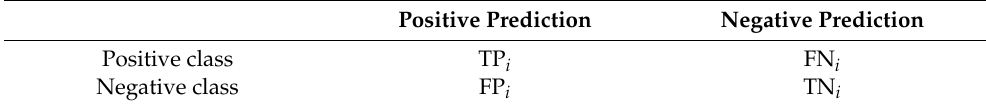
Table 4. Predicting results for class i